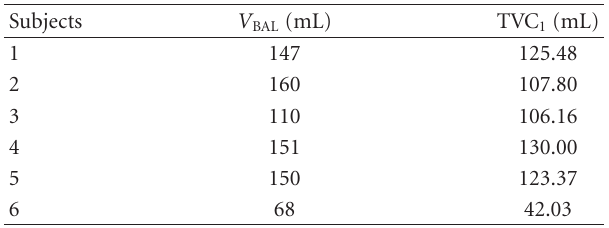
Table 2: Statistics of V BAL and TVC 1 for each